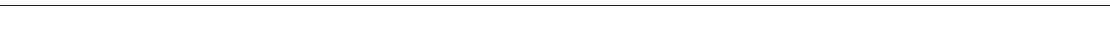
Fig. 4 The GABAergic system suppresses the gene expression of the Imd pathway. a Regulation of immune-related genes in the AaGABA A -R1 -silenced mosquitoes. Two independent dsRNAs were exploited to knockdown the AaGABA A -R1 gene in A. aegypti , respectively. The GFP dsRNA-treated mosquitoes served as controls. The total RNA was isolated on 3 days post dsRNA inoculation for RNA-Seq analysis. Immune-related genes were clustered according to immune pathways and factors. b – g Regulation of Imd -related genes by AaGABA A -R1 silencing in A. aegypti . AaGABA A -R1 was silenced by two independent dsRNAs. GFP dsRNA-treated mosquitoes served as controls. Expression of AaImd b , AaRel2 c , AaDef-A d , AaDef-C e , AaDef-D f and AaCec-N g were determined by SYBR Green qPCR at 3 days post dsRNA microinjection. h – k Knockdown of AaImd enhanced virus infection in A. aegypti . h Inoculation of AaImd dsRNA signi fi cantly suppressed the AaImd expression. Mosquitoes inoculated with GFP dsRNA served as negative controls. AaImd abundance